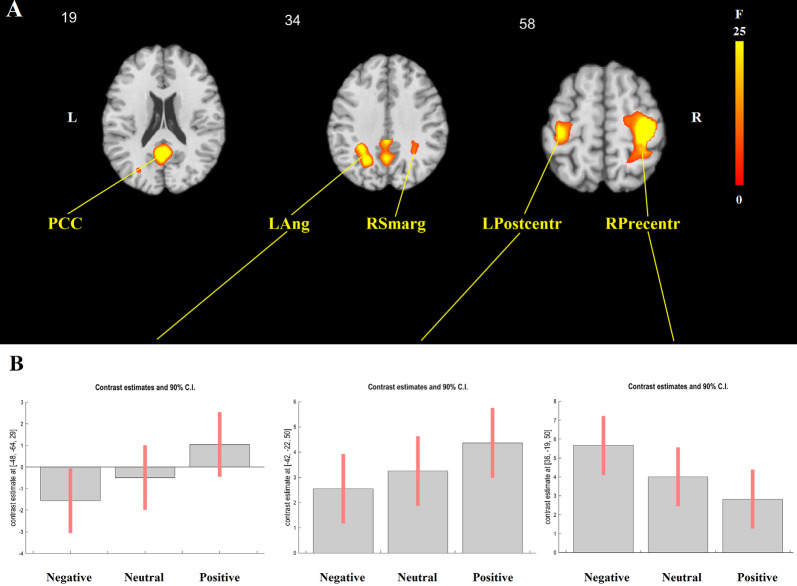
GLM results. The main effect of adjective valence. (A) The localization of significant clusters. (B)
F Contrast for the effects of interest. From left to right: contrast estimates and 90% confidence intervals for BOLD activation during the presentation of negative, neutral, and positive adjectives in the left angular gyrus (LAng), the left postcentral gyrus (LPostcentr), and the right precentral gyrus (RPrecentr). In the posterior cingulate cortex (PCC) and the right supramarginal gyrus (RSmarg), the pattern was similar to the one shown for the left angular gyrus.